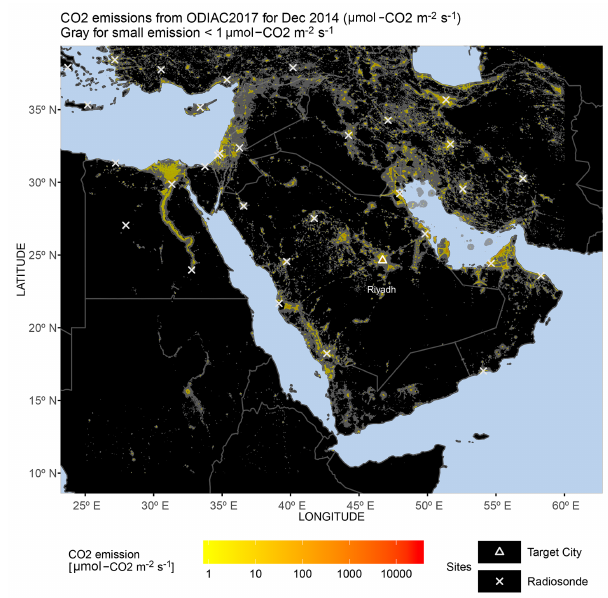
Figure 4. Monthly ODIAC emissions (yellow to orange) in log- scale at 1km × 1km grid spacing for December 2014. White crosses and the triangle denote the radiosonde networks used to provide the wind error statistics and our study site of Riyadh, respectively. Small emissions ( < 1µmolm − 2 s − 1 ) are shaded in